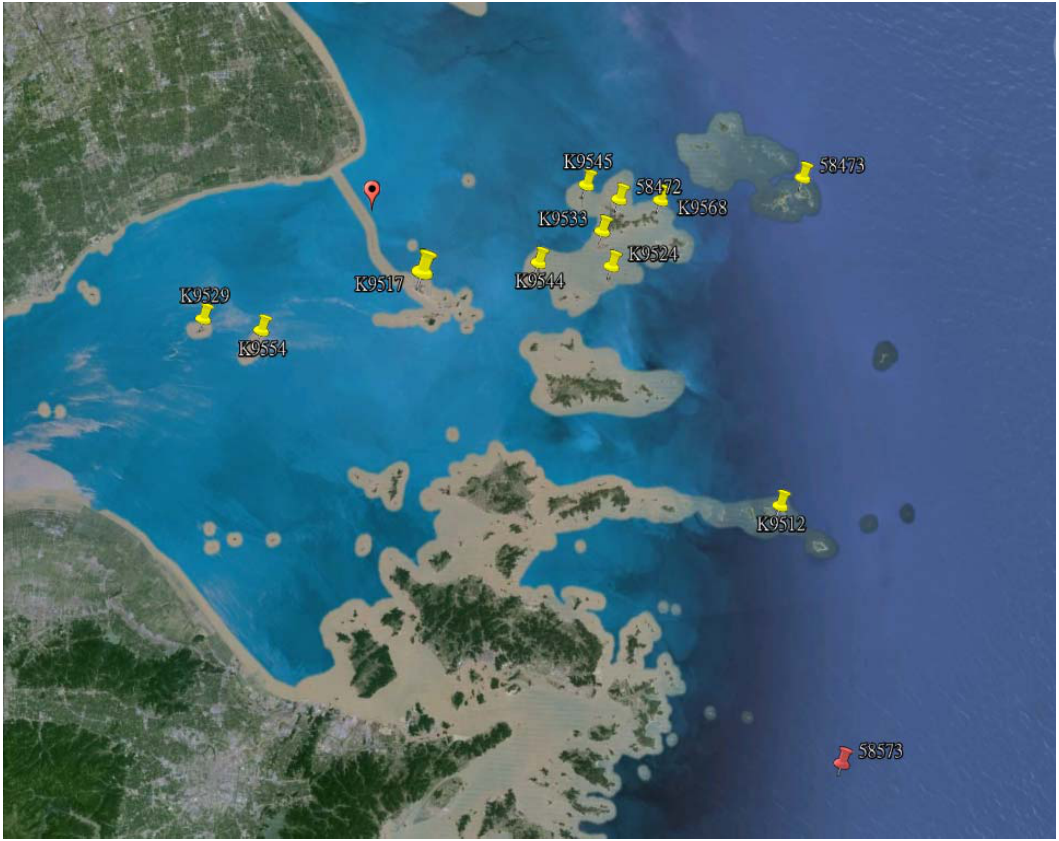
Figure 1. Spatial distribution of in situ sites over Hangzhou Bay, China. Image coutesy Google